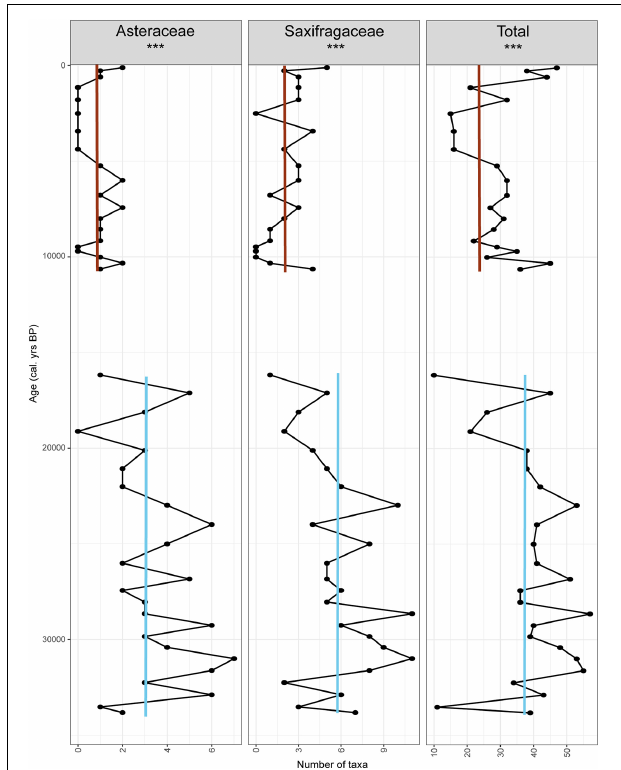
FIGURE 9 | Richness count (total and within the most represented families). Red lines indicate average values in the Holocene interglacial while blue lines indicate the average during the last glacial